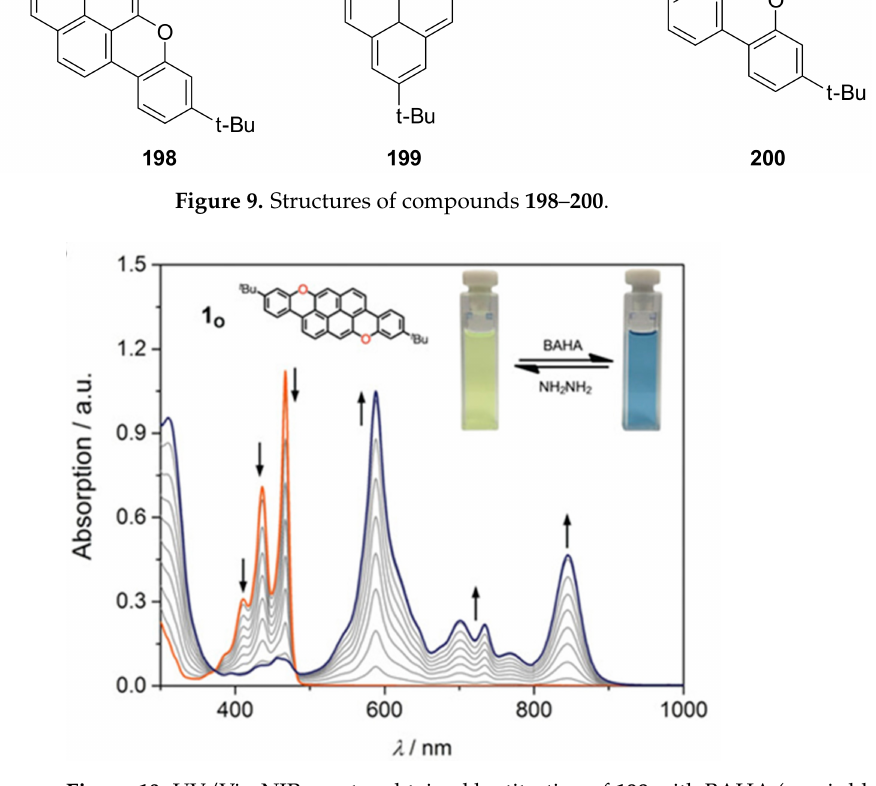
Figure 10. UV/Vis–NIR spectra obtained by titration of 198 with BAHA (magic blue) in dry CH 2 Cl 2 at 298 K (Reproduced with permission from Ðor ¯devi´c et al., Angewandte Chemie International Edition; published by German Chemical Society (GDCh),